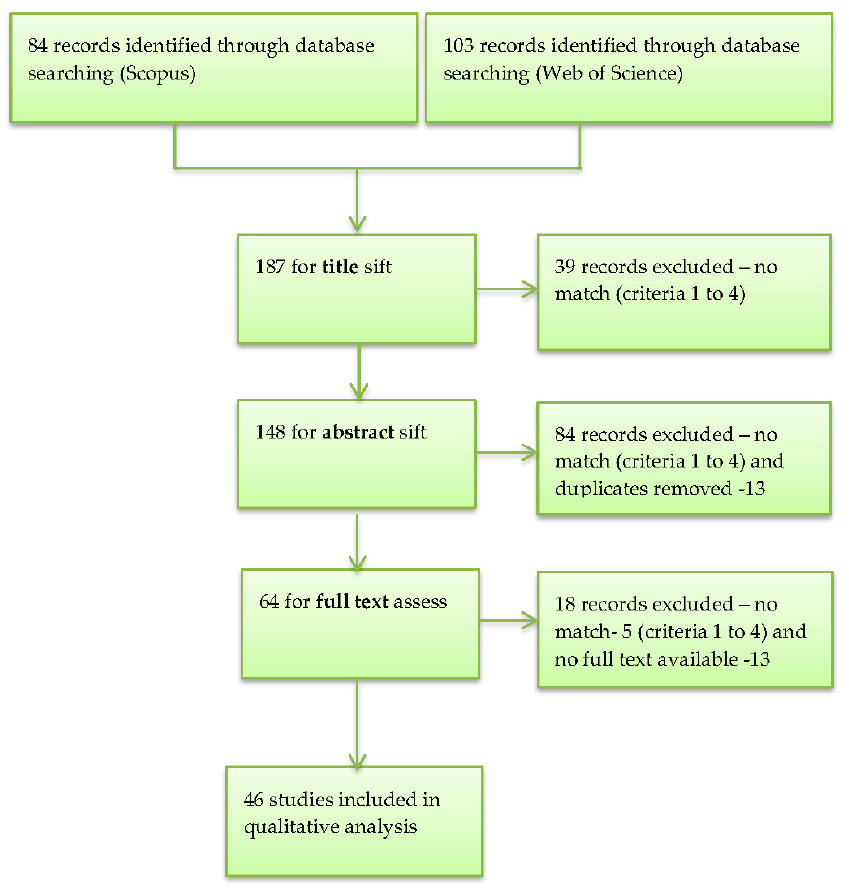
Figure 1. Flow chart for selection of articles for systematic review [5].